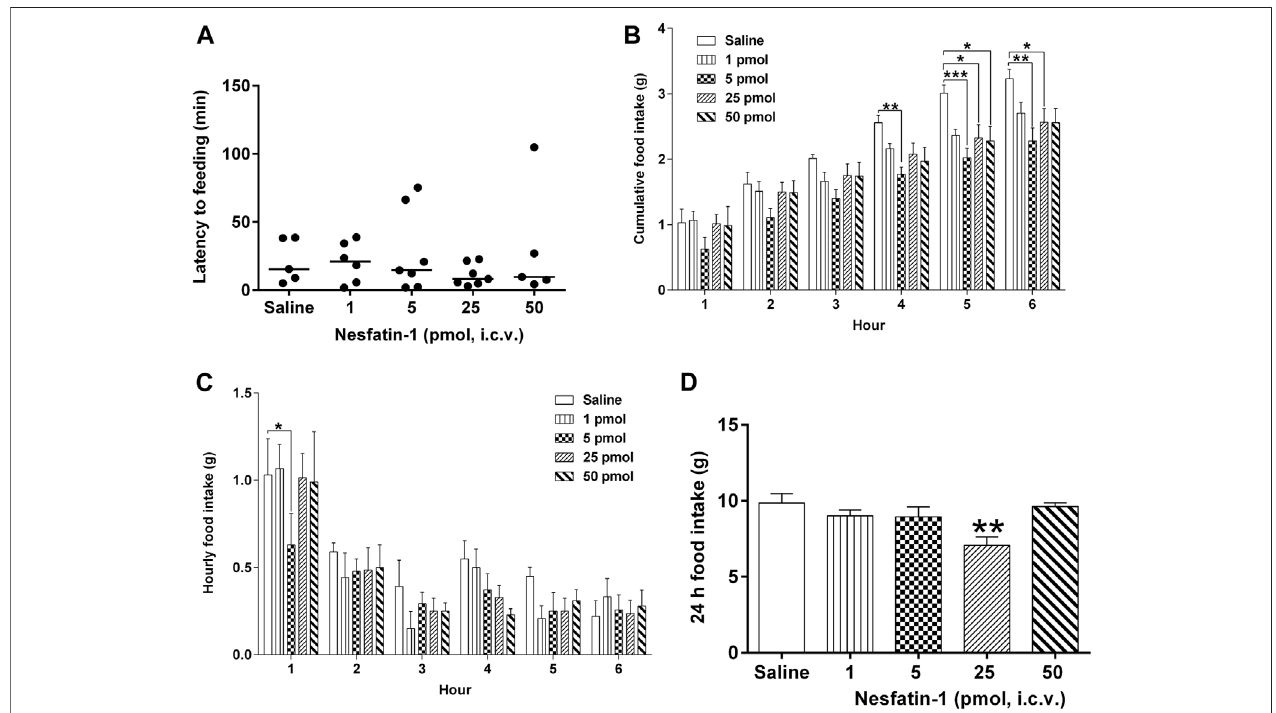
FIGURE 6 | Effects of intracerebral drug administration on food intake in Suncus murinus . (A) Latency to food intake, (B) cumulative food intake from 0 to 6 h, (C) hourly food intake from 0 – 6 h, and (D) cumulative food intake at 24 h after an i.c.v. administration of saline (5 μ l, i.c.v.) or nesfatin-1 (1 – 50 pmol, i. c.v). The results represent the mean ± s. e.m. of 5 – 7 determinations during a period of 24 h. Latency data are shown as individual responses, with lines indicating the median response time.Signi fi cantdifferencesbetweenthetreatmentgroupsareindicatedas p p < 0.05, pp p < 0.01and ppp p < 0.001(one-wayANOVAortwo-wayANOVA,followed by Bonferroni